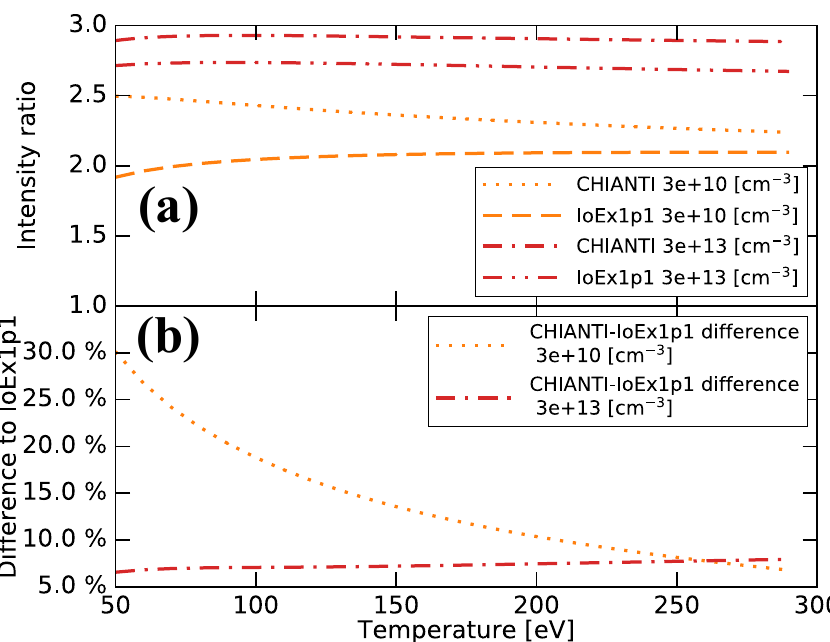
Figure 13. ( a ) Intensity ratio as function of electron temperature calculated with our model IoEx1p1 and CHIANTI for electron densities 3 × 10 10 cm − 3 and 3 × 10 13 cm − 3 . ( b ) Difference between two